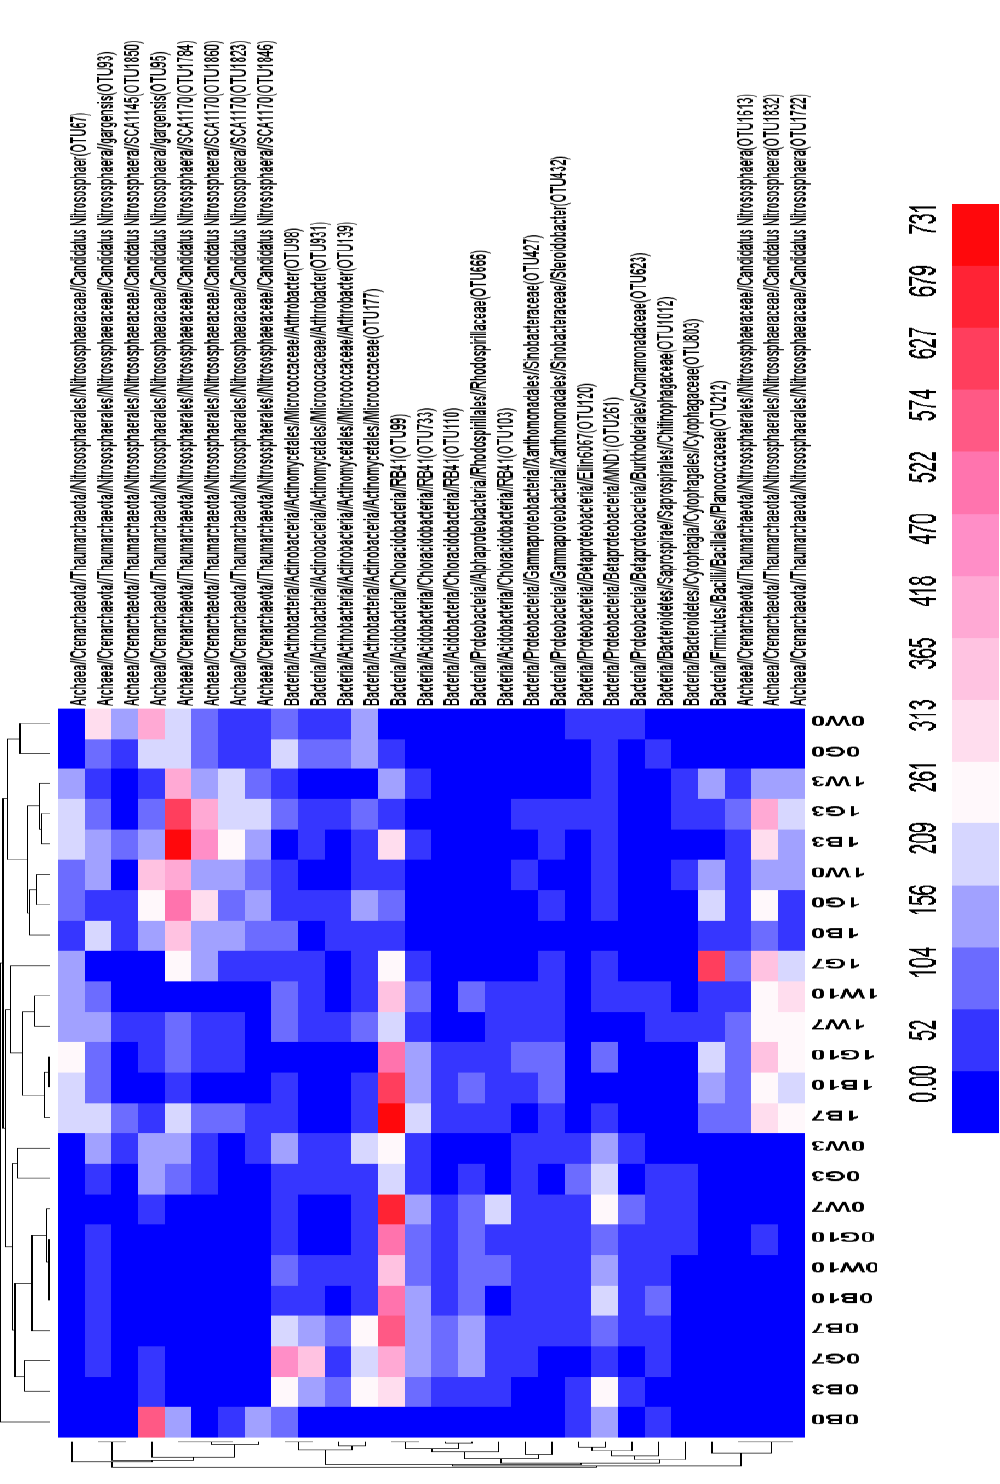
Figure 3. Heatmap of 24 samples based on the correlation between environmental factors and the abundance of dominant groups. The color intensity of the scale represents the microbial community relative abundance with respect to the abundance of each OTU relative to all bacterial sequences.